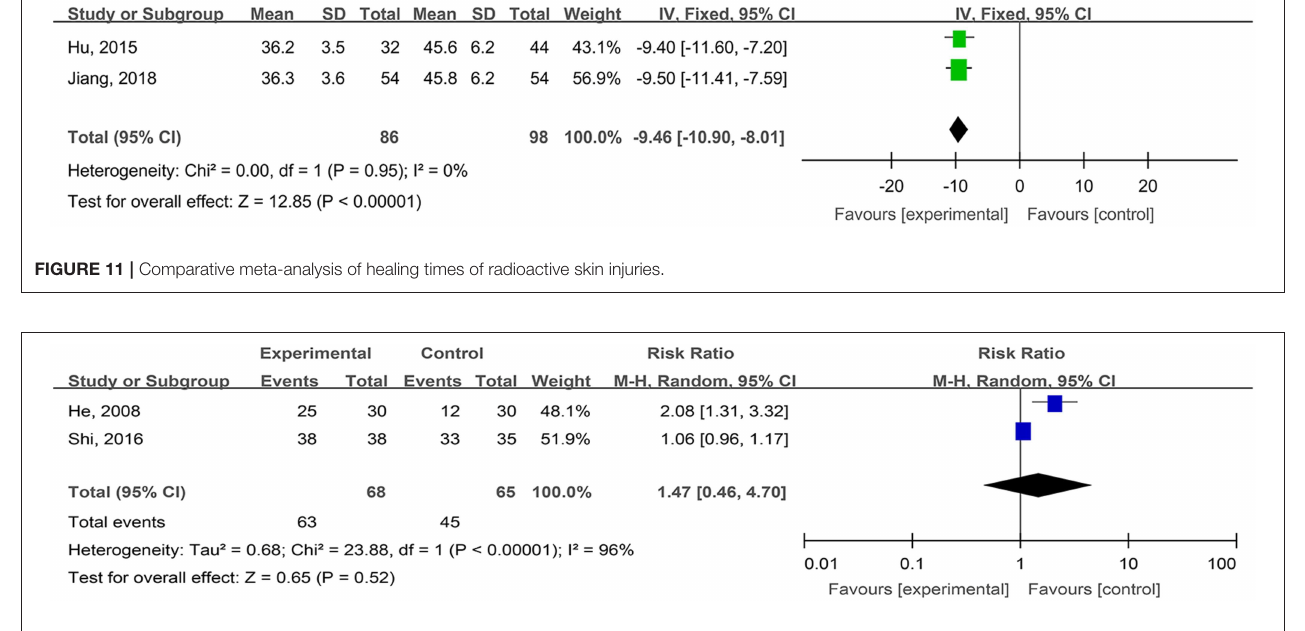
FIGURE 12 | Comparative meta-analysis of cure rates of phlebitis